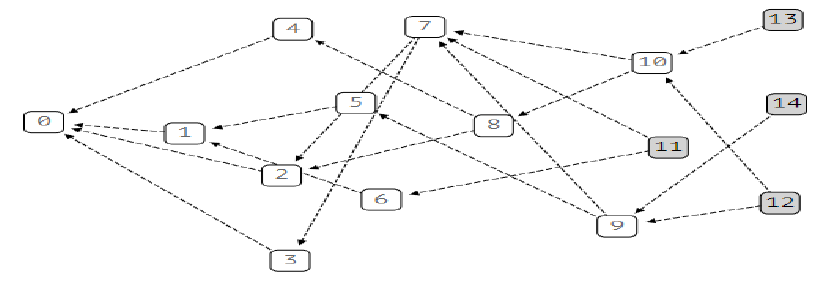
Figure 3. Tangle network.